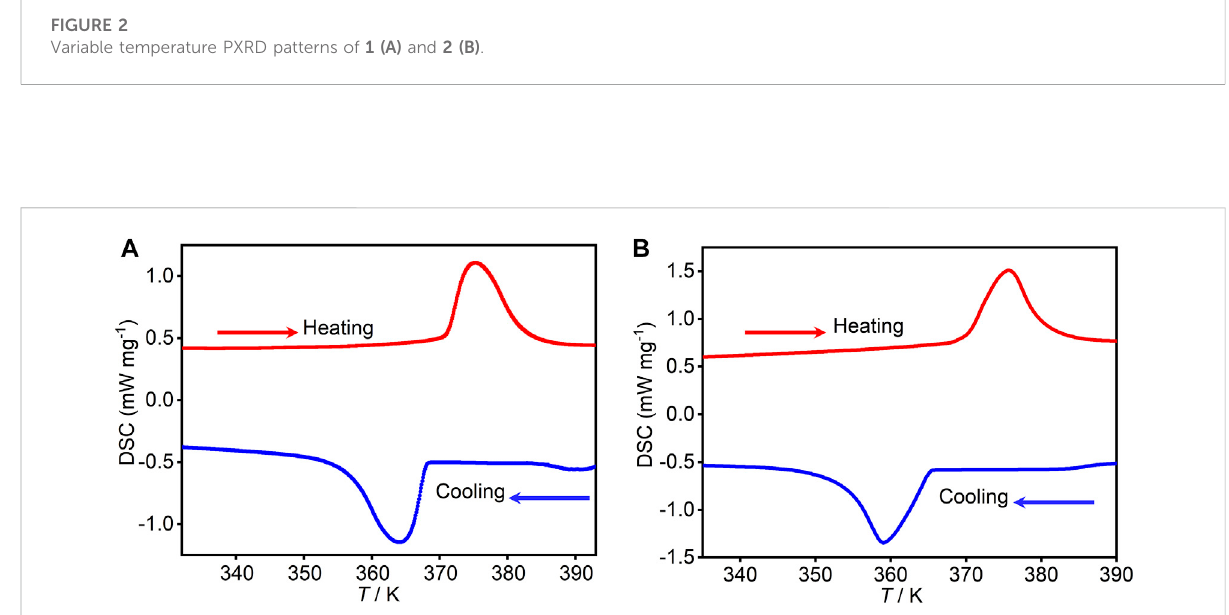
FIGURE 3 DSCcurvesof 1(A) and 2(B) measuredundernitrogenandatmosphericpressureataheating/coolingrateof20 Kmin − 1 atatemperaturerange of 330 – 400